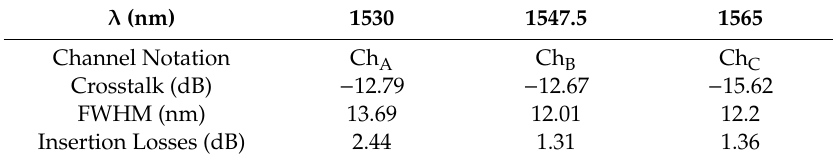
Figure 9. Optical spectrum around the C-band. Table 3. Values of the insertion loss (IL), crosstalk, and FWHM for the operational wavelengths. λ (nm)